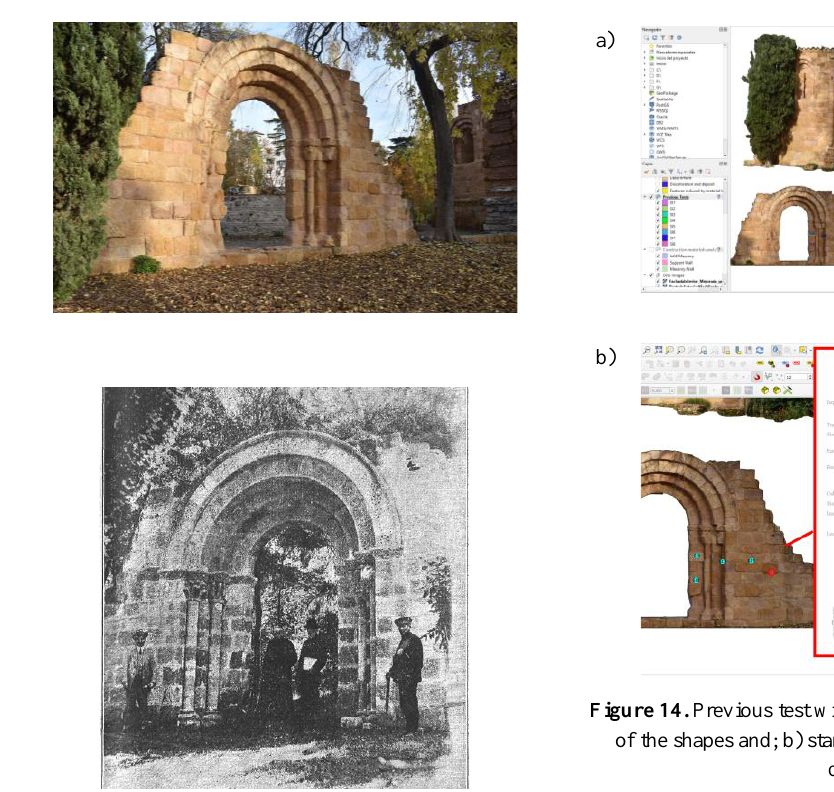
Figure 13. State of conservation: a) current status; b) appearance at 1915 (Real Academia de la Historia, 1916).